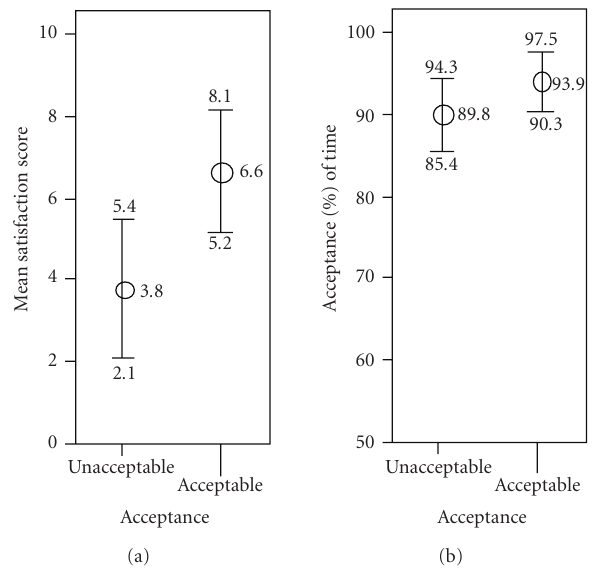
Figure 11: Relations on the scale between retrospective acceptance and satisfaction; and retrospective acceptance and acceptance based on continuous assessment. Bars show mean and standard